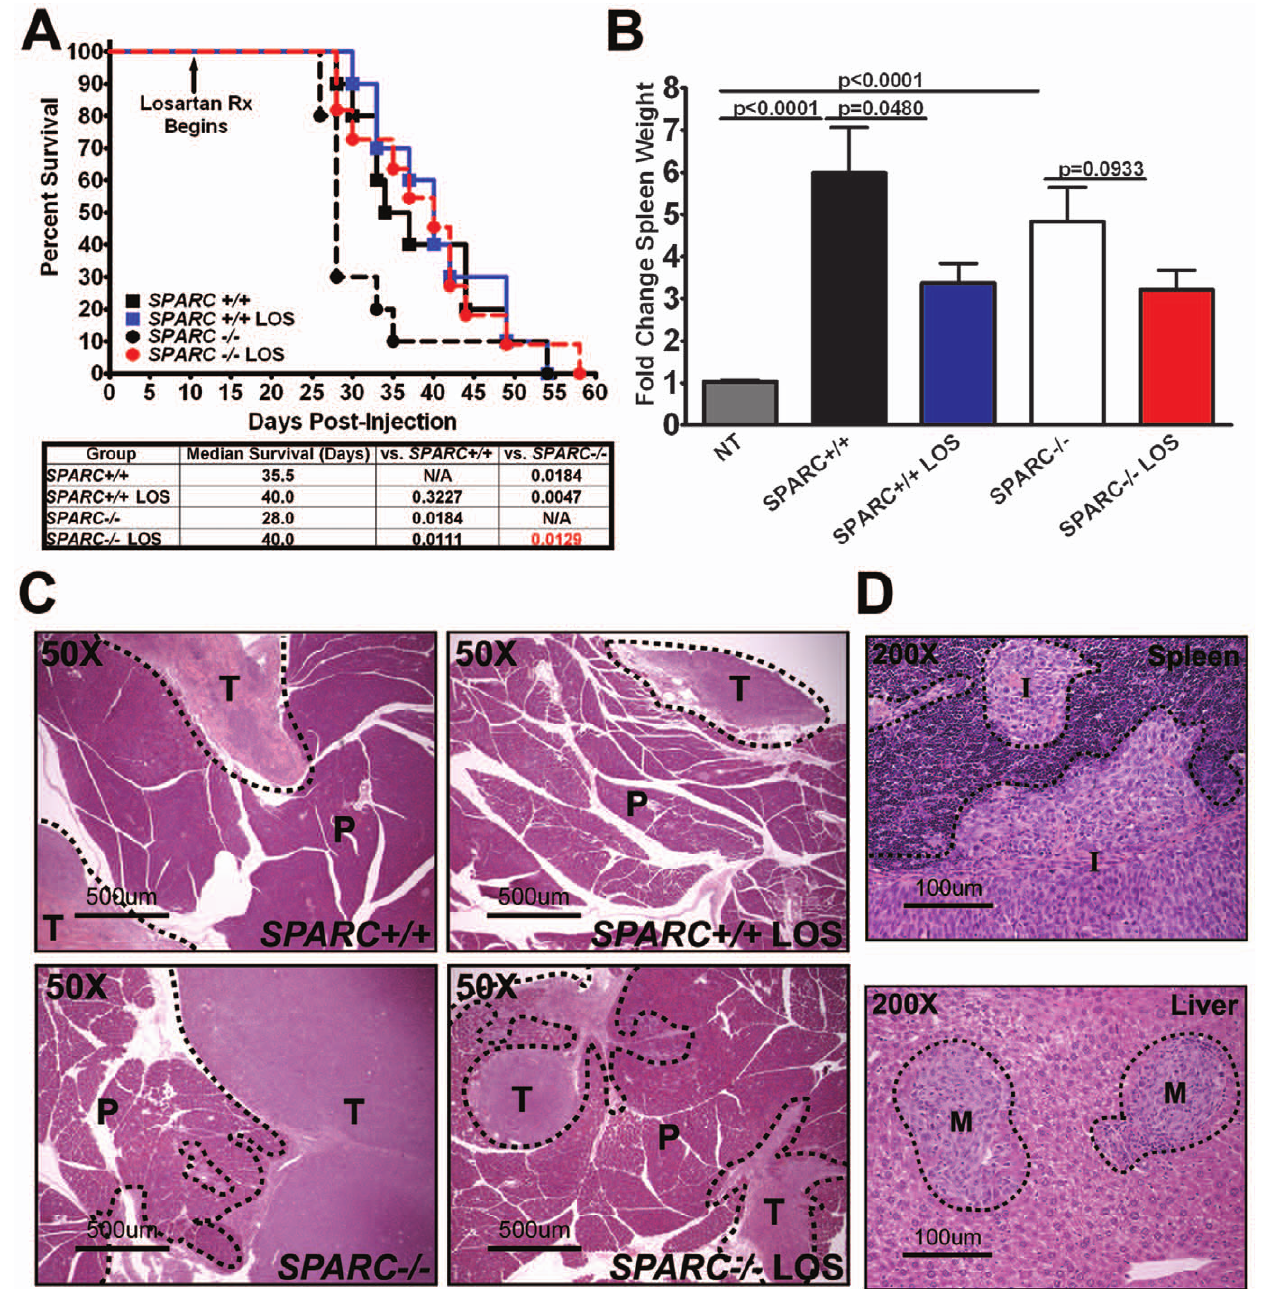
Figure 2. Losartan improves survival of tumor-bearing SPARC 2 / 2 mice. A–C) 1 6 10 6 Pan02 cells were injected into the tail of the pancreas of SPARC + / + and SPARC 2 / 2 mice. Tumors were allowed to grow for 10 days prior to initiation of losartan therapy (600 mg/L) via drinking water ad libitum in 2% sucrose. A) Survival curve of SPARC + / + and SPARC 2 / 2 mice treated with losartan (LOS). The table lists the median survival and associated p-values calculated with the Gehan-Breslow-Wilcoxon test (n=10/group). The survival curve is modified from Arnold et al 2010 [23]. B) Graph displays spleen weight and the fold change calculated based on the weight of spleens taken from non-tumor bearing (NT) mice. Significance was determined by a Student’s t-test and all significant p-values are indicated. C, D) 1 6 10 6 Pan02 cells were injected into the tail of the pancreas of SPARC + / + and SPARC 2 / 2 mice. Losartan therapy was given as above was initiated 24 hours after tumor cell injection and mice were sacrificed 28 days later. (C) Images of H&E stained primary tumor sections show residual pancreas and the primary tumor border of untreated and losartan-treated (LOS) SPARC + / + and SPARC 2 / 2 mice. Dotted lines demarcate the normal adjacent pancreas (P) from the primary tumor (T). Total magnification (50 6 ) and scale bars (500 m m) are indicated. (D) H&E section of a spleen displaying disruption of the splenic capsule and local tumor invasion (I). Total magnification (200 6 ) and scale bars (100 m m) are shown. Image of an H&E stained liver section revealing the common site for distant metastasis (M). Total magnification (200 6 ) and scale bars (100 m m) are indicated.